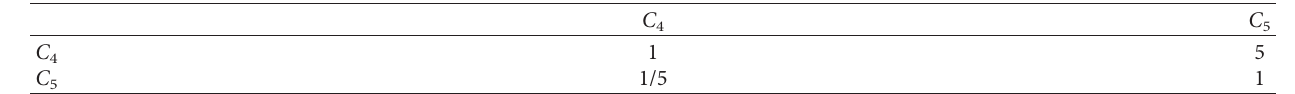
Table 5: Secondary index judgment matrix in U